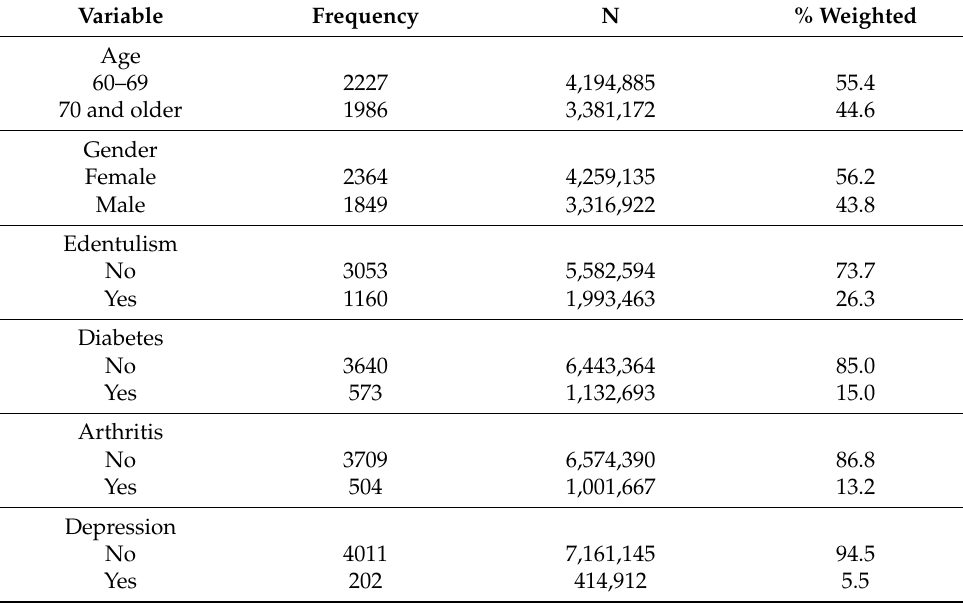
Table 1. Variables from Mexican subjects aged 60 and